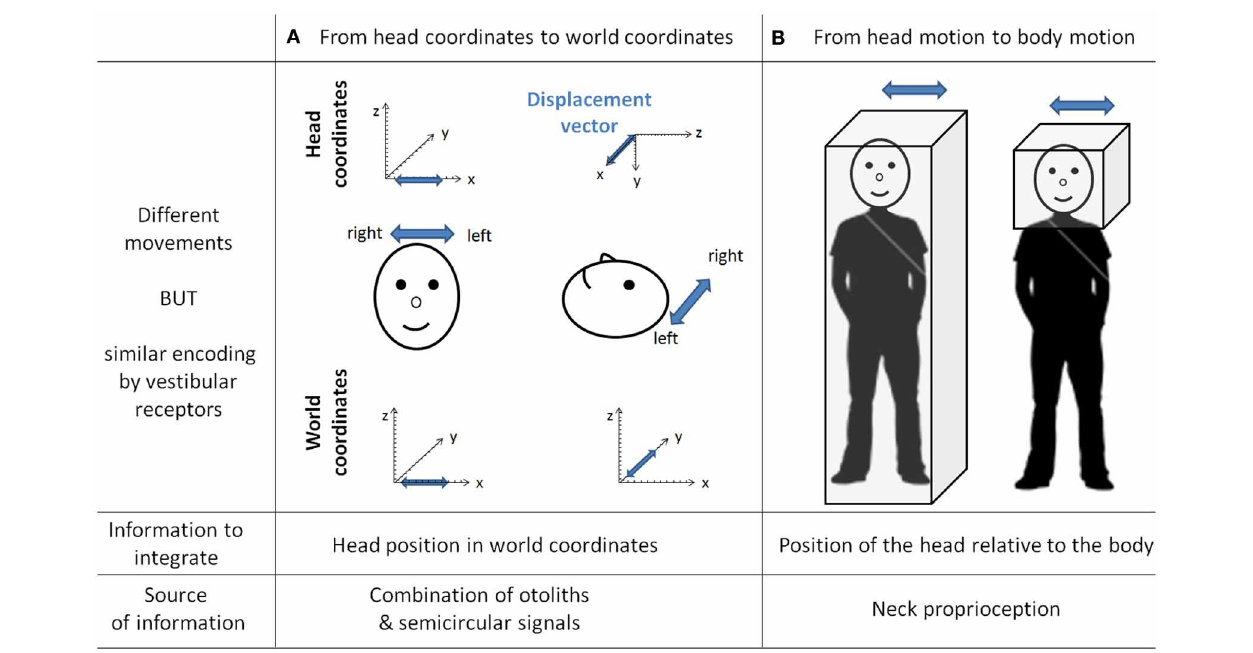
FIGURE 4 | The need for transformation of the vestibular signals. As the vestibular organs are located in the head, vestibular signal is detected in head coordinates. This implies several transformations of the vestibular signal to correctly compute body motion in space. This figure gives two examples of different movements similarly encoded by vestibular receptors. In column (A) is a linear displacement from left to right, with the head either vertical or horizontal. Indeed both movements are identical in the head reference frame [displacement vectors (in blue) project onto the x-axis] whereas they are different in the world coordinates